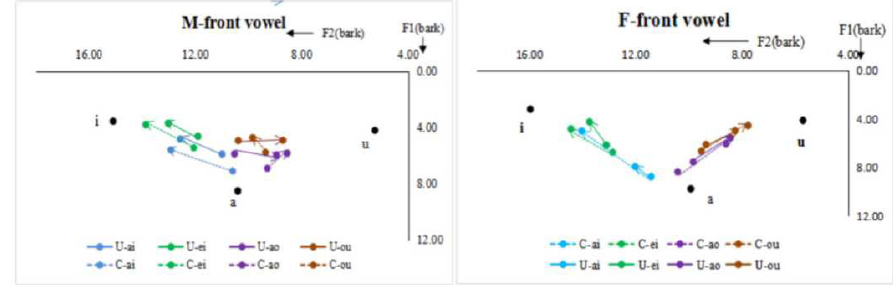
Fig. 6 Vowel chart of front vowel acoustics for advanced level learners and standard speakers.